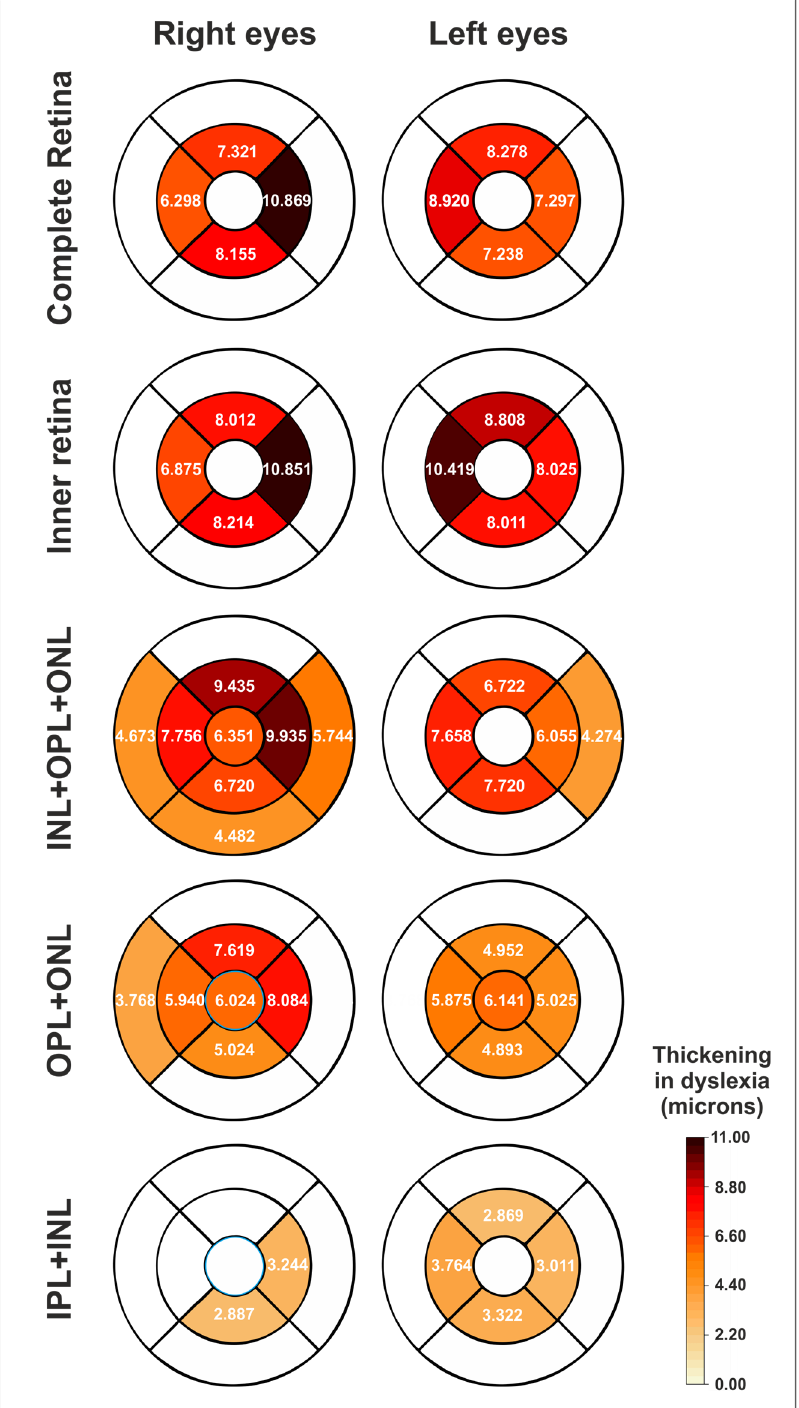
Figure 2. Schematic heatmaps of the statistically significant thickenings (expressed as microns) in the dyslexic group compared to the normal control group for the right and left eyes (mean differences in thickness) and for different segmentations. See also Figure 1a–c. White sectors indicate no significant differences. IPL = inner plexiform layer, INL = inner nuclear layer, OPL = outer plexiform layer, ONL = outer nuclear layer. See also Tables S1–S4 and S7.